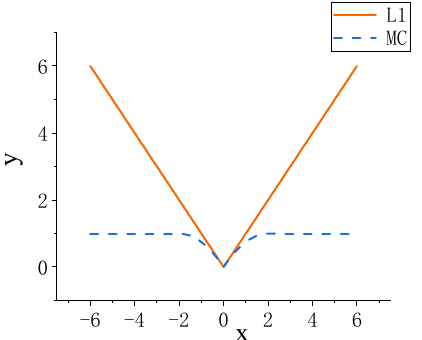
Figure 1. Comparison of L1 norm and MC penalty.